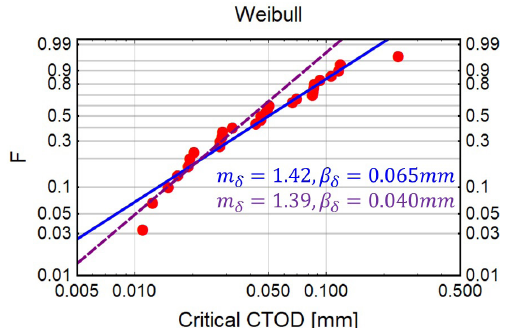
Figure 10. Comparison of the experimental and predicted statistical distribution of critical